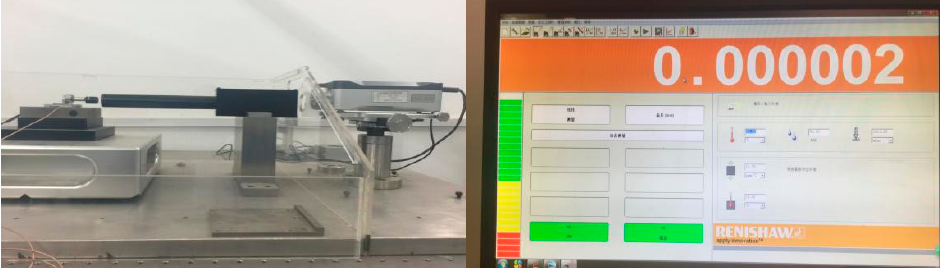
Figure 5. XL-80 laser interferometer ((Renishaw plc, Gloucestershire, UK)).